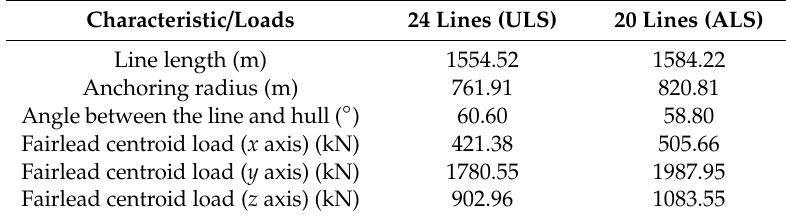
Table 3. Characteristics of the mooring lines and loads of the line applied in the fairlead centroid.